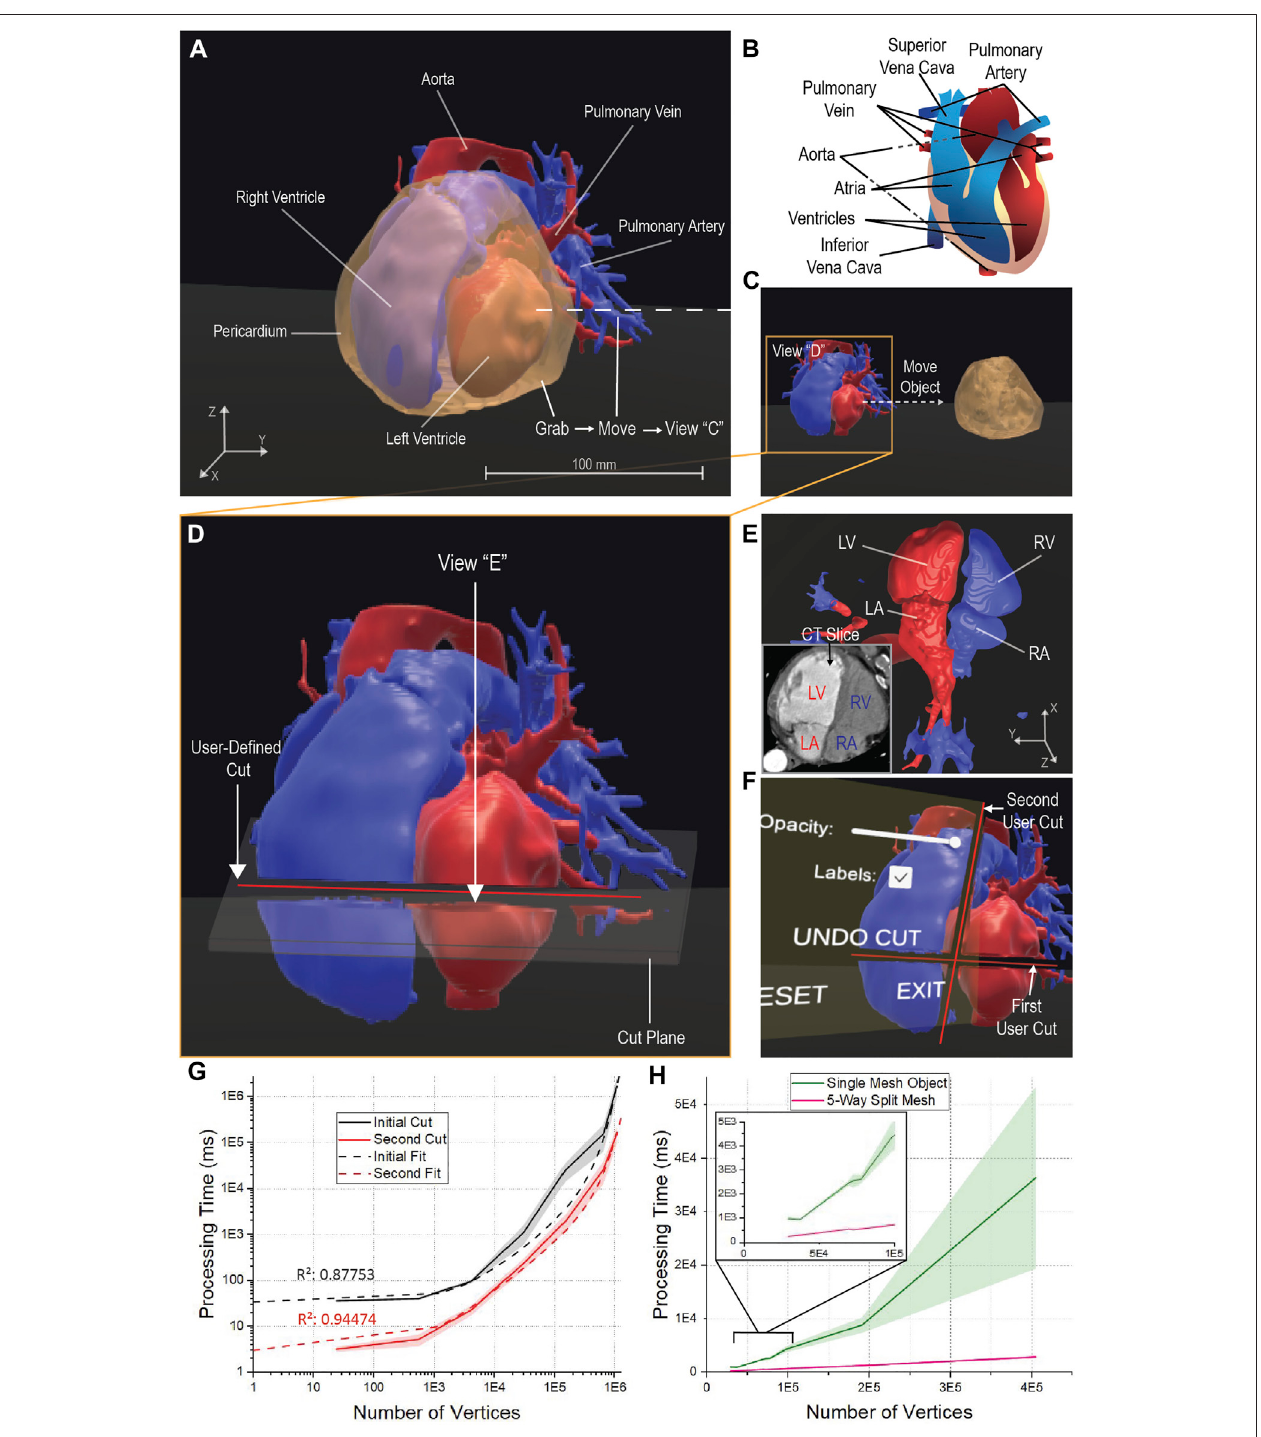
FIGURE 3 | VR Platform Manipulative Functionalities on a CT Heart Model. The framework generates an immersive biologically accurate 3-D model (A, B) and allows the user to interactively manipulate the model bypassing the pre-de fi ned operations. The user accesses a grab function to directly alter the model and move the cardiac pericardium from an initial position (A) to a secondary position (B) . The grab function allows for a focused perspective on the ventricles, atria, veins, and arteries that may require further applied manipulations, such as a cut (D) . The user de fi nes a speci fi c line to form a plane that splits the targeted ventricles and atria (D) , allowing for alternate analysis to be taken from the generated perspectives of the cut plane (E ). The user can utilize the generated perspective to further verify the model according to the initial CT data (E) or explore differing views; LV: Left Ventricle; LA: Left Atrium; RV: Right Ventricle; RA: Right Atrium. The functionality of the platform